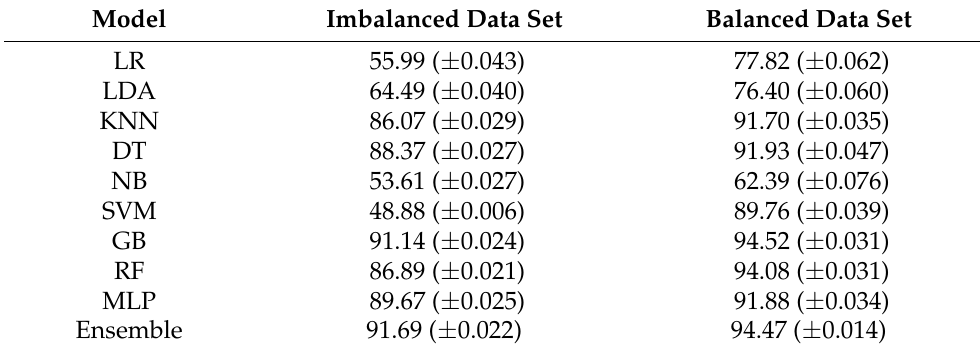
Table 4. F1-macro results (in %) and associated standard deviation for model